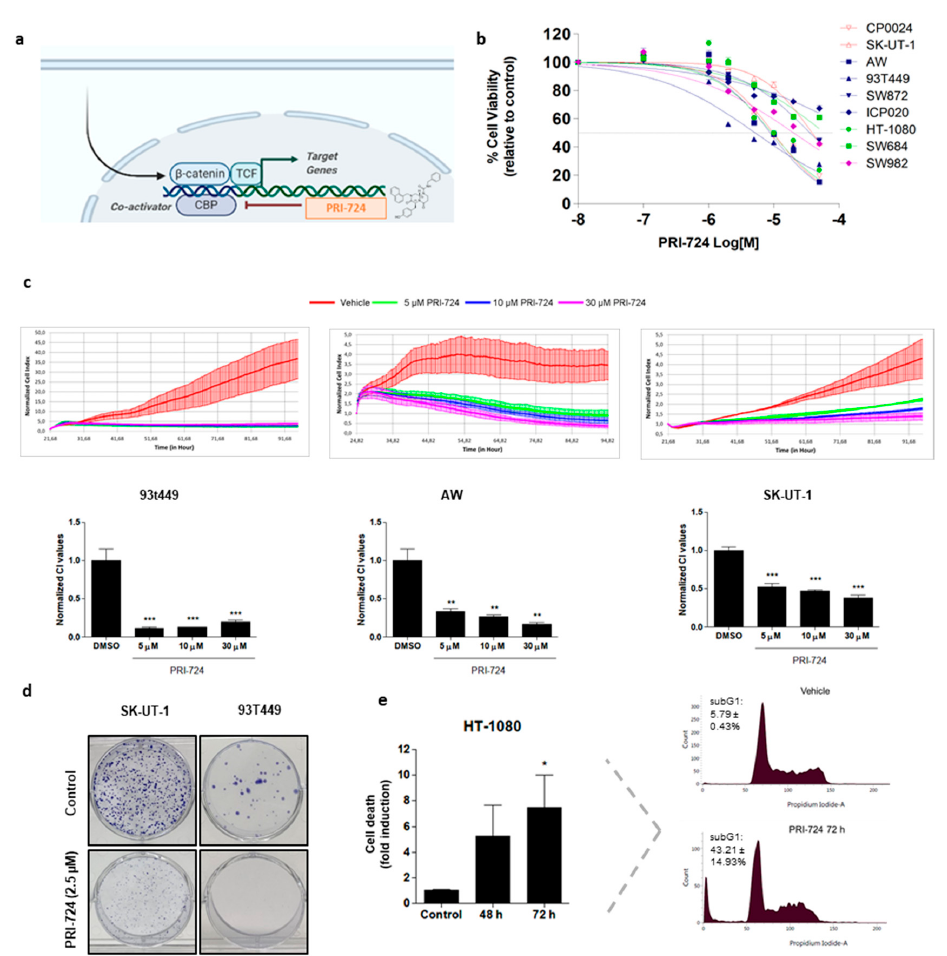
Figure 1. Inhibition of the interaction between β -catenin and its transcriptional coactivator CBP suppresses cell viability and colony formation of STS cell lines. ( a ) PRI-724 inhibits β -catenin interaction with its co-activator CBP. ( b ) STS cells were treated with PRI-724 (0.1–50 µM) and cell viability was determined after 48 h. Data is represented as mean ± SEM percentage of cell viability relative to